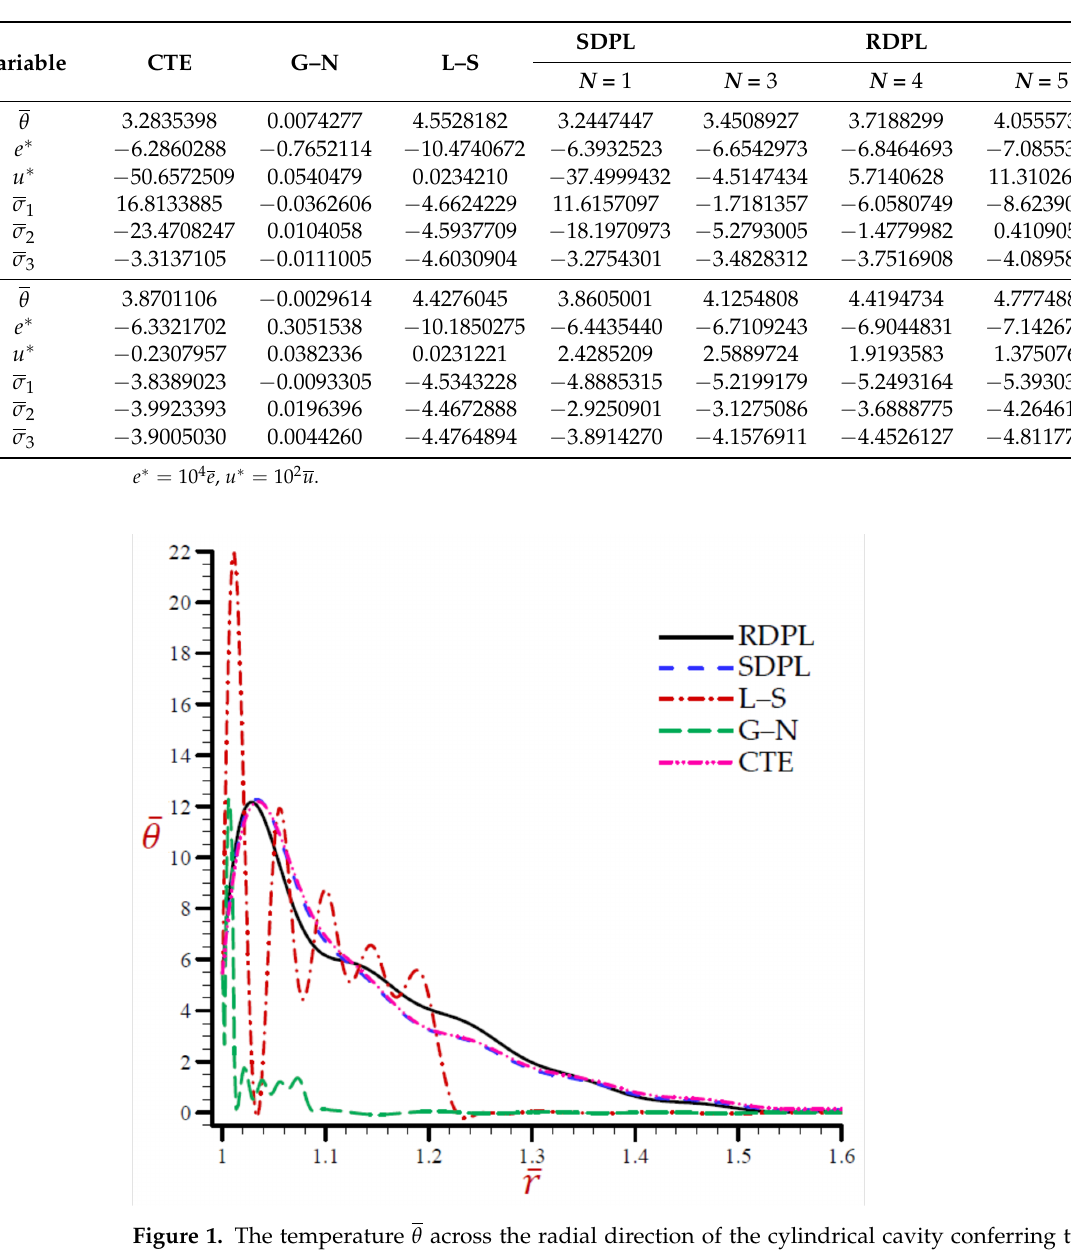
Table 2. Effect of the velocity of heat source ϑ on the field variables of different thermoelasticity theories with t = 0.03, r = 1.2, ω = 20.